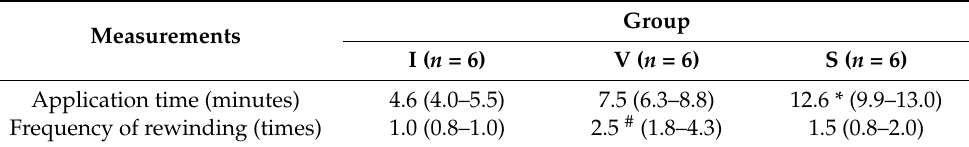
Table 3. Bandage application time (minutes) and the frequency of bandage rewinding (times) in the immobilization